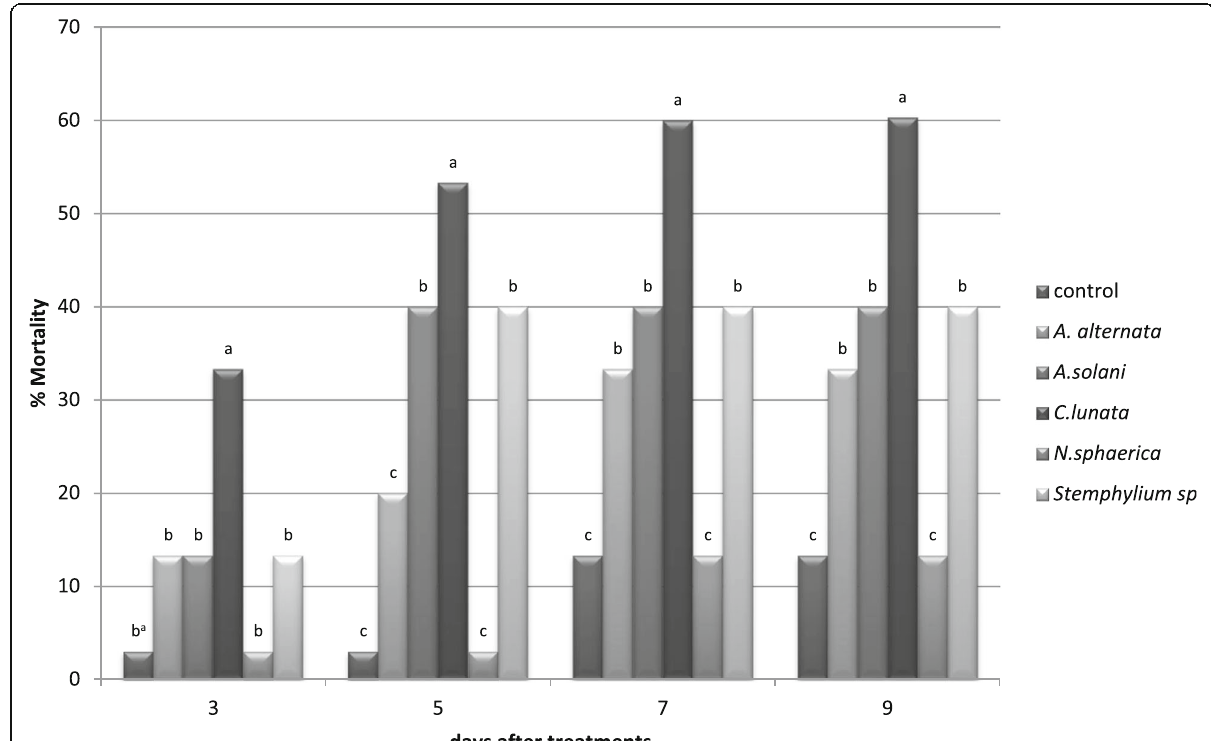
Fig. 4 Pathogenicity of endophytic fungi on third-instar larvae of Spodoptera littoralis by dipping in spore suspension (10 8 spores/ml). (a) Percent mortality within the same day sharing the same letter is not significantly different at the 0.05 probability level